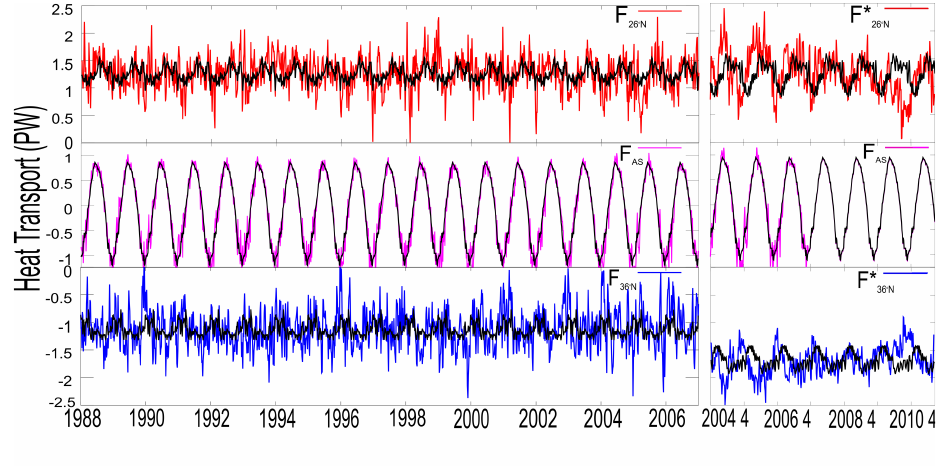
Fig. 2. The MHT and air–sea flux (PW) used to force the box model, for AV (left, as described in Sect. 2.2) and FV (right, as described in Sect. 2.3, starting in April 2004) experiments. Positive (red) transports enter the box at 26 ◦ N, while negative transports (blue) leave the box at 36 ◦ N. The air–sea flux ( F AS , magenta) can be positive or negative. Black lines illustrate the seasonally varying climatology components of the respective forcing. For the F AS component for the observational case, the OCCAM-derived NCAR forcing was used up to December 2006, and the seasonally varying climatology thereafter. The right figure starts in April 2004, as this is when the RAPID-based estimates become available.